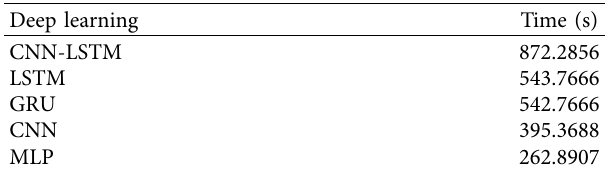
Table 15: Computational time for deep learning